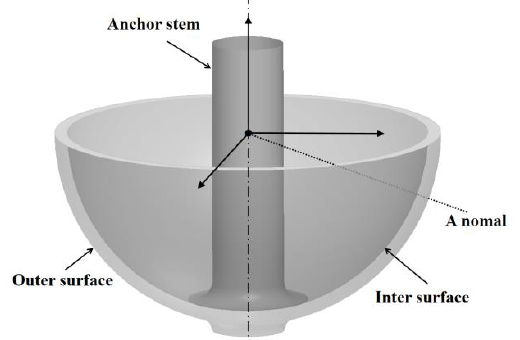
Figure 1. Structure of a hemispherical shell resonator.